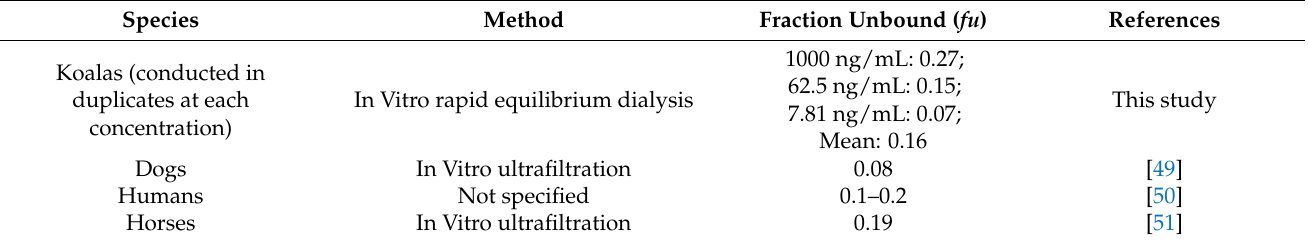
Table 6. The unbound fraction ( fu ) of doxycycline when interacting with koala plasma proteins, and the plasma proteins of other species using various